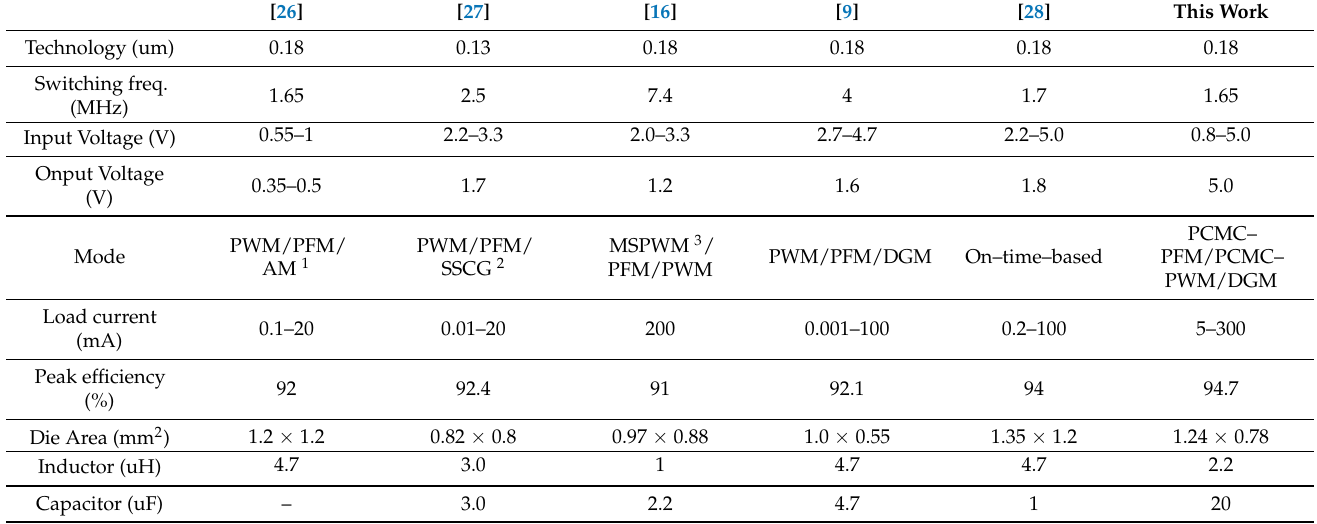
Table 1. Performance comparison with prior